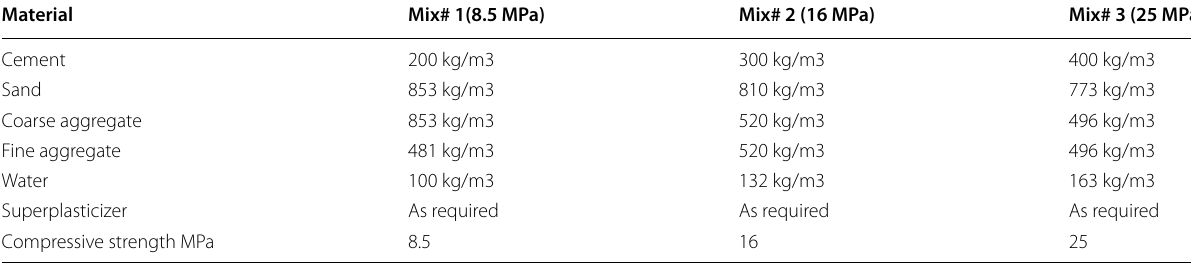
Table 2 Mixture proportions of concrete